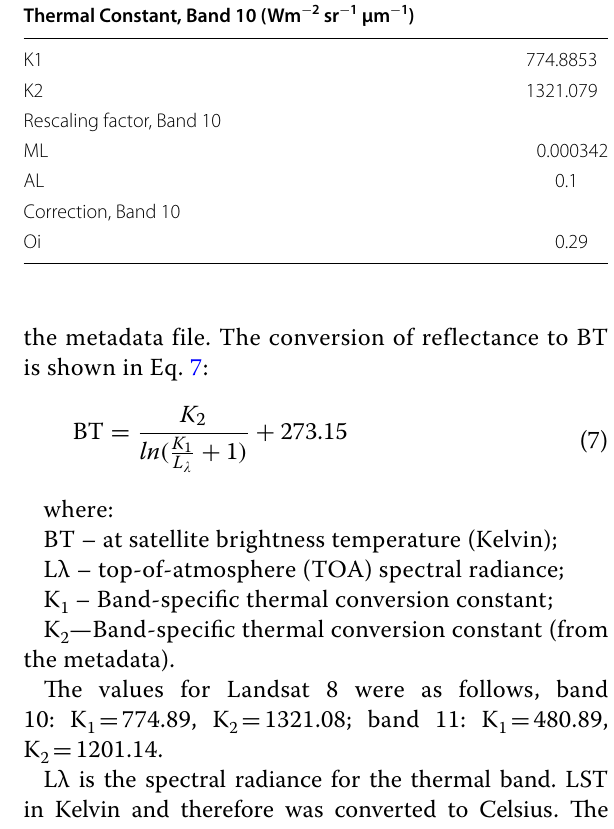
Table 3 Metadata of the satellite images